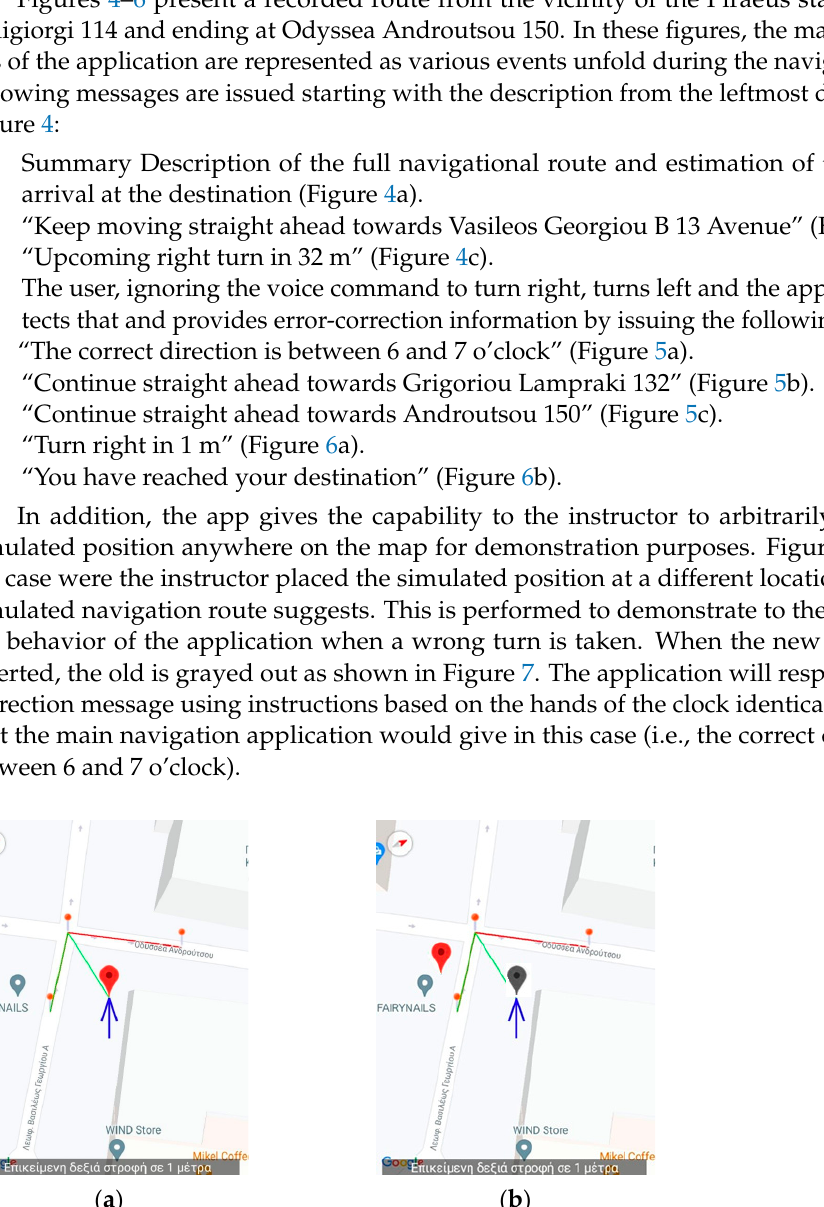
Figure 8. Specially mounted external device on a real traffic light located at the junction of Doiranis and Athinas in Kallithea. The application in combination with the latter device helps the blind user to pass traffic light crossings by detecting the traffic light status changes and by reporting the duration in which the traffic light remains in the green status. Figure 9a depicts the user approaching the traffic light and the messages issued. When the user has reached the traf- fic light, the application, then, informs the user of the event and instructs the user to wait for 20 s, the time required for the traffic light to change to the green status at the time of the recording. When the traffic light is green, then the application issues a message re- questing the user to pass the traffic light crossing in 25 s as shown in Figure 9b, which is the time until the green status changes to another state at the time of recording.